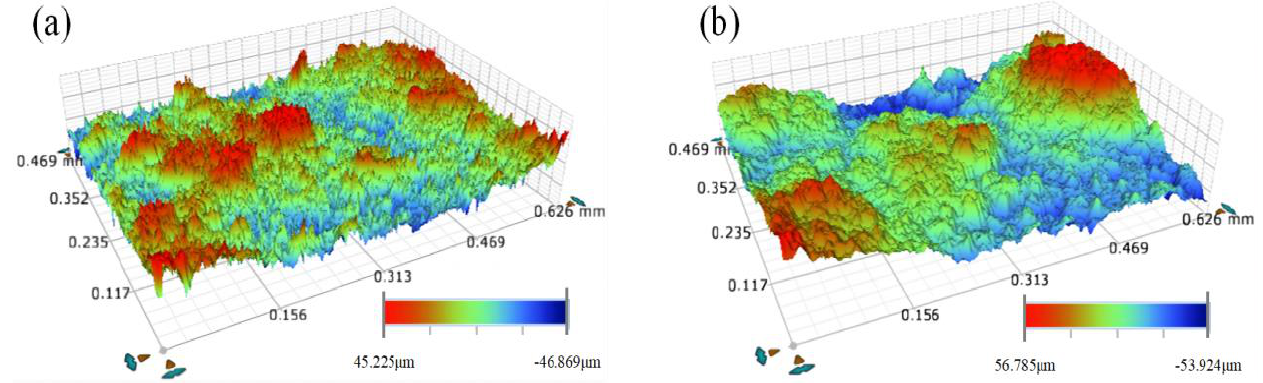
Figure 6. Surface morphology of ( a ) micro Al 2 O 3 coating; ( b ) nano Al 2 O 3 coating.